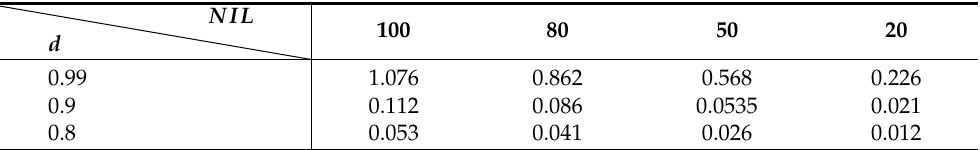
Table 1. Total Search time of SSA-MAFA (in seconds) for one search layer, where d , decreasing coefficient of the standard jump amplitude; NIP , number of inner loops for the search procedure with one standard jump